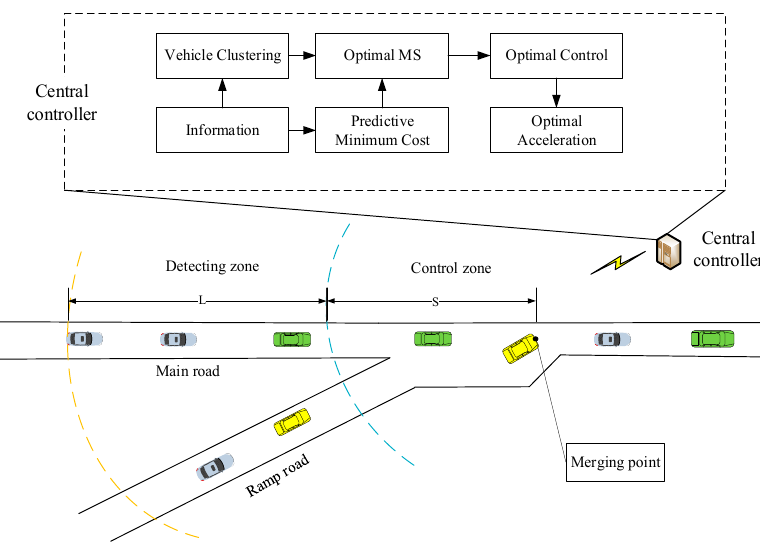
Figure 1. Framework for merging sequence decisions and control systems.